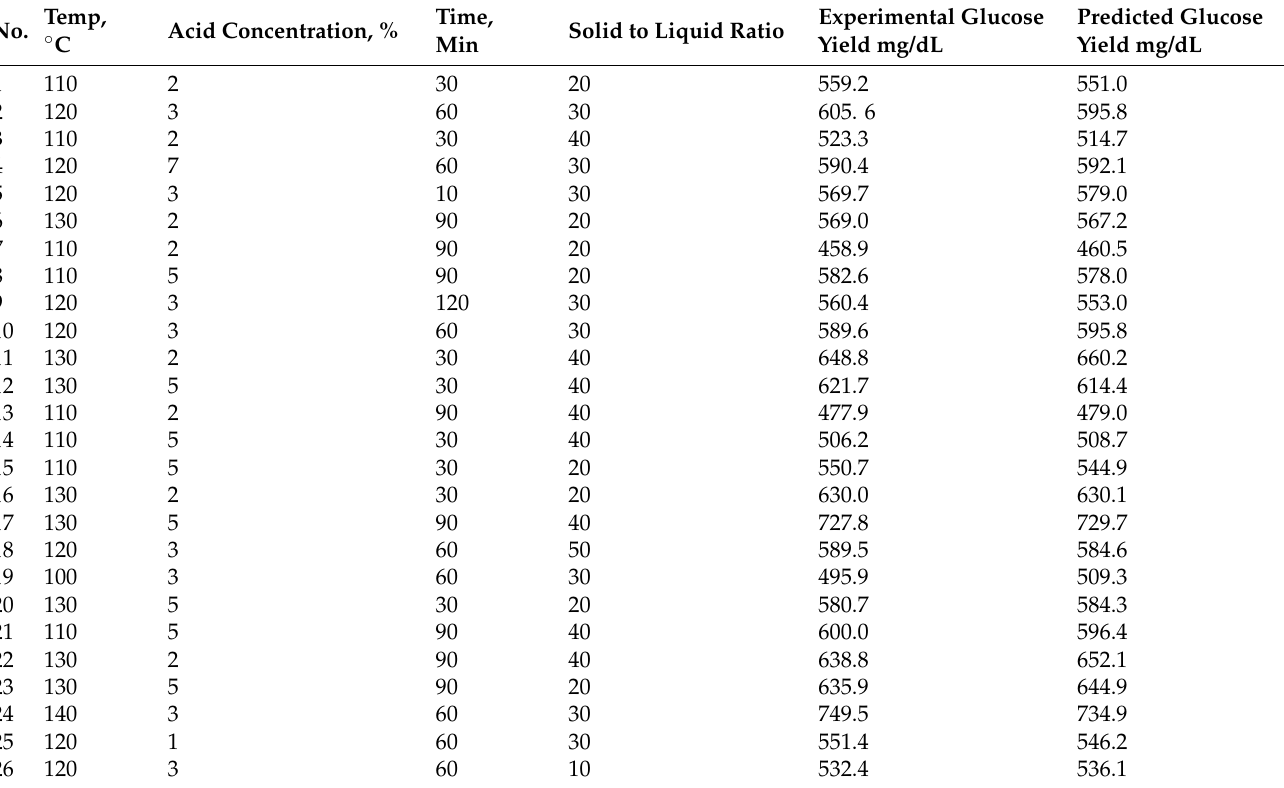
Table 3. Experimental design matrix of autoclave-assisted oxalate pretreatment, applied to CS, considering the variables temperature, oxalic acid concentration, time, and solid to liquid ratio, and the response, namely, produced glucose yield in 96 h of enzymatic saccharification.